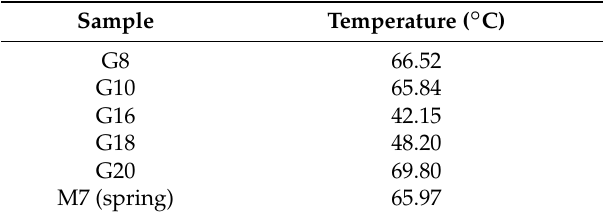
Table 2. SiO 2 geochemistry temperature scale calculation of groundwater samples.